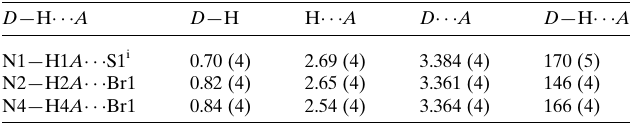
Table 1 Hydrogen-bond geometry (A˚ , (cid:4) ) for (1).